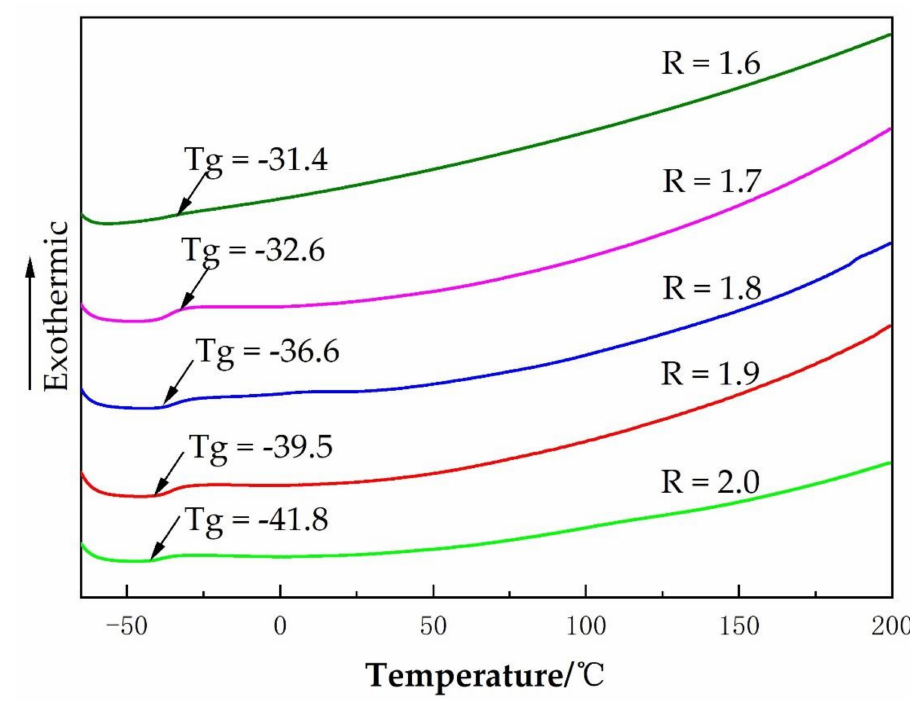
Figure 8. DSC curves of SPU films with different R